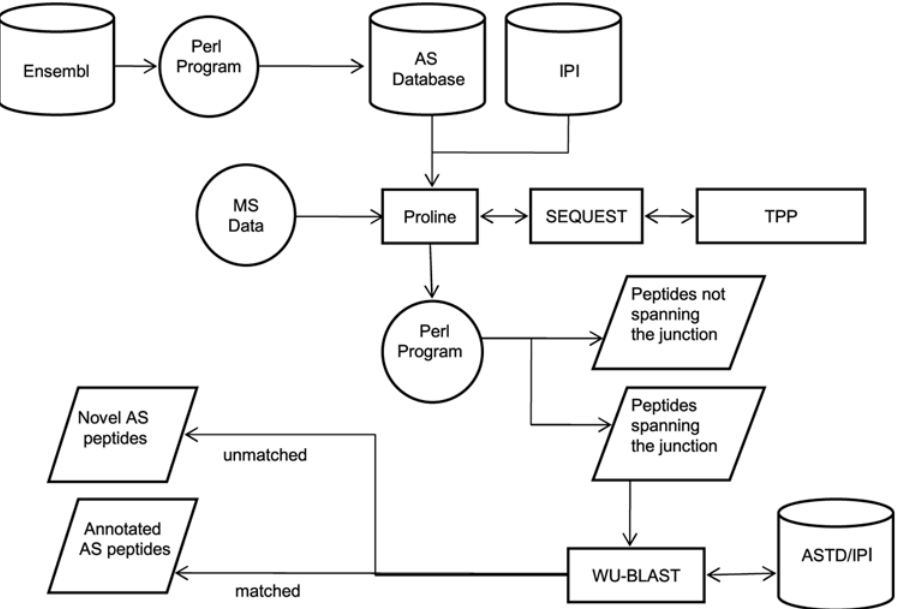
Figure 1. Workflow for the identification of novel exon skip events. A rectangle represents a program, rhombus represents a program output, cylinder represents a data source and circle represents a program input.